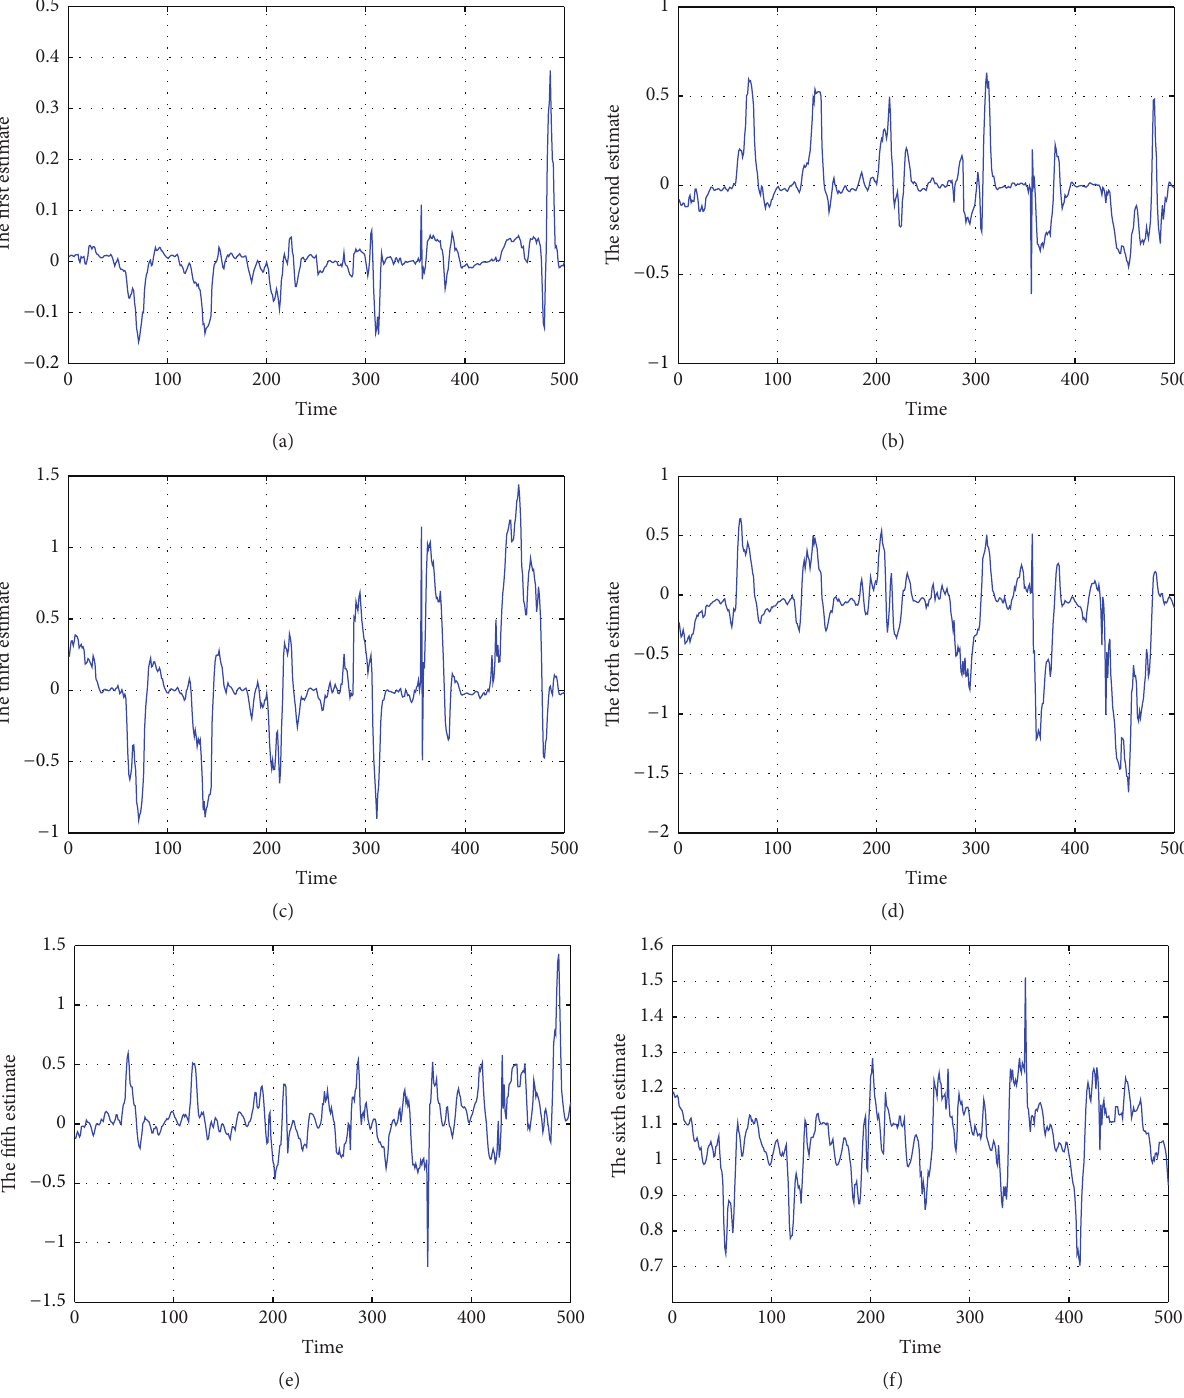
Figure 5: The functional coefficients’ estimations: (a)–(f) the estimated values from 𝑥 𝑡−(𝑚−1)𝜏 to 𝑥 𝑡 ,